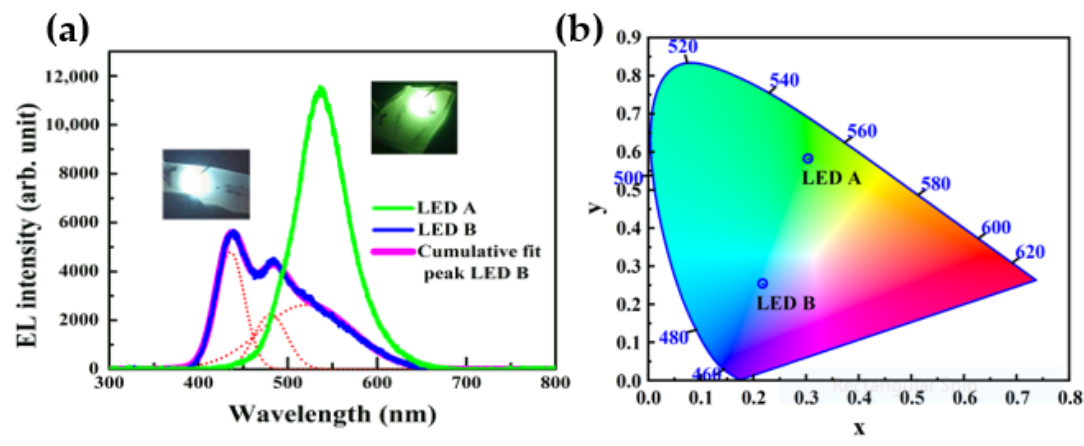
Figure 4. ( a ) EL spectra with the inset images of light emission, ( b ) corresponding CIE color coordi- nates based on the CIE 1931 chromaticity diagram, of sample LED A and B measured under direct injection current of 20 mA.